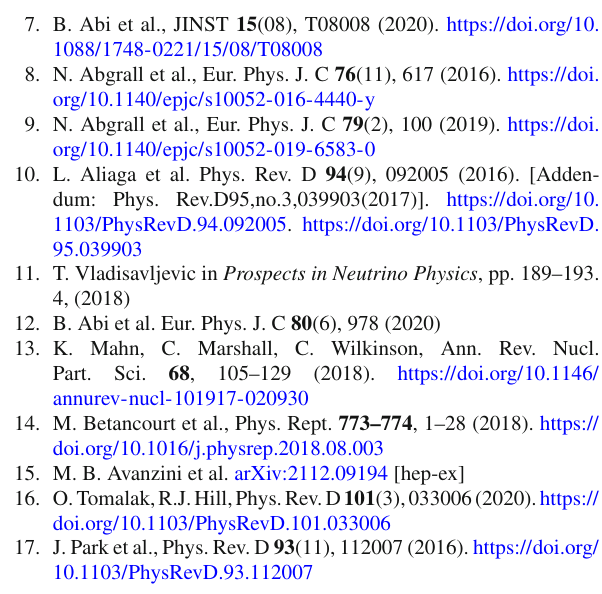
Fig. 15 Comparison of the shape-only ratios (with respect to the GENIEv3 10a prediction) of the ν μ –C n H 2 n and ¯ ν μ –C n H 2 n charged- current cross section with a cut on 0.3 GeV for the three different proxy variables, E true , E reco and E avail , as a function of E true ν . Figures pro- had had